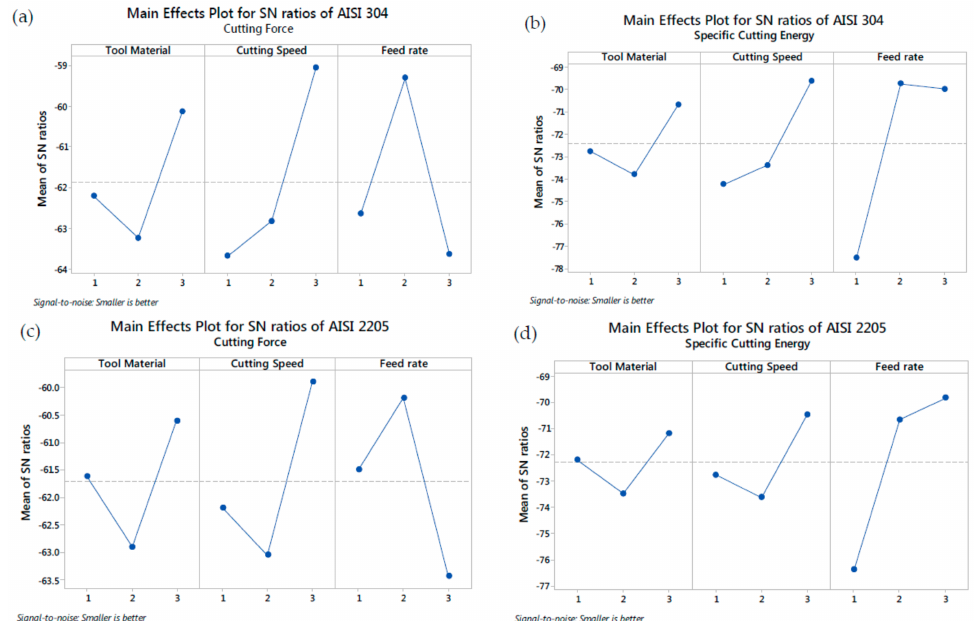
Figure 4. Mean signal to noise (S/N) ratio graph for ( a , c ) cutting force and ( b , d ) specific cutting energy of ( a , b ) AISI 304 and ( c , d ) AISI 2205 stainless